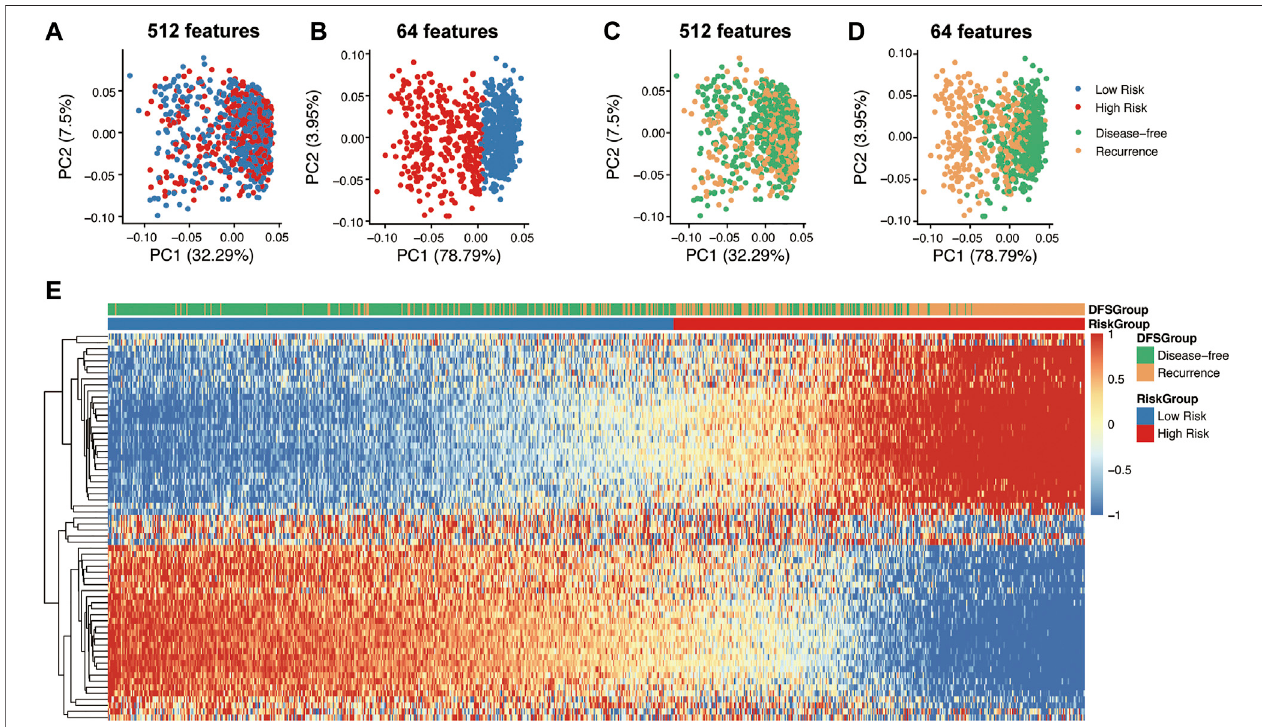
FIGURE 4 | Dimension reduction for visualization and correlation analysis of deep CT features. Principle component analysis (PCA) on the 512 features of the ResNet34 network (A,C) and 64 features (CT feature) of hidden notes of the FC network (B,D) . Correlation heatmap between 64 deep CT features and prognostic difference group (E)